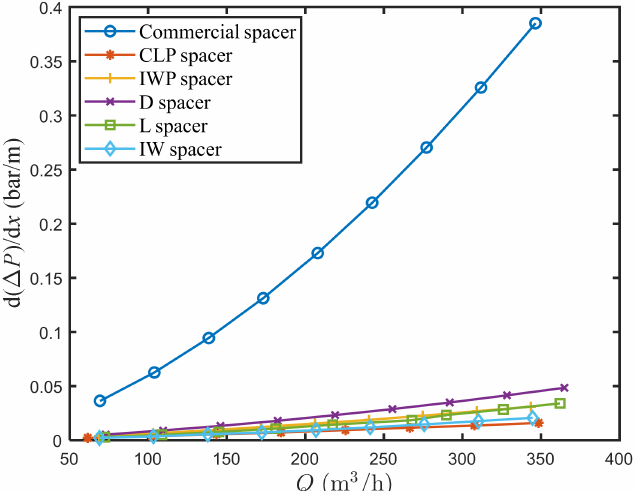
Figure 9. Comparison of pressure drop for Commercial, CLP, IWP, D, L, and IW spacer-filled channels obtained from 3D simulations.